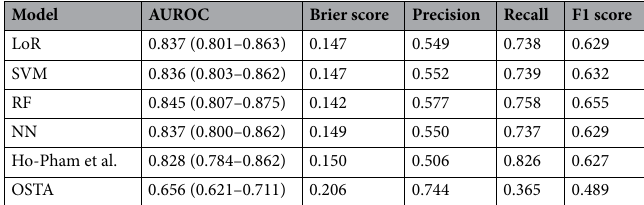
Table 6. The performances of the models in the second scenario.